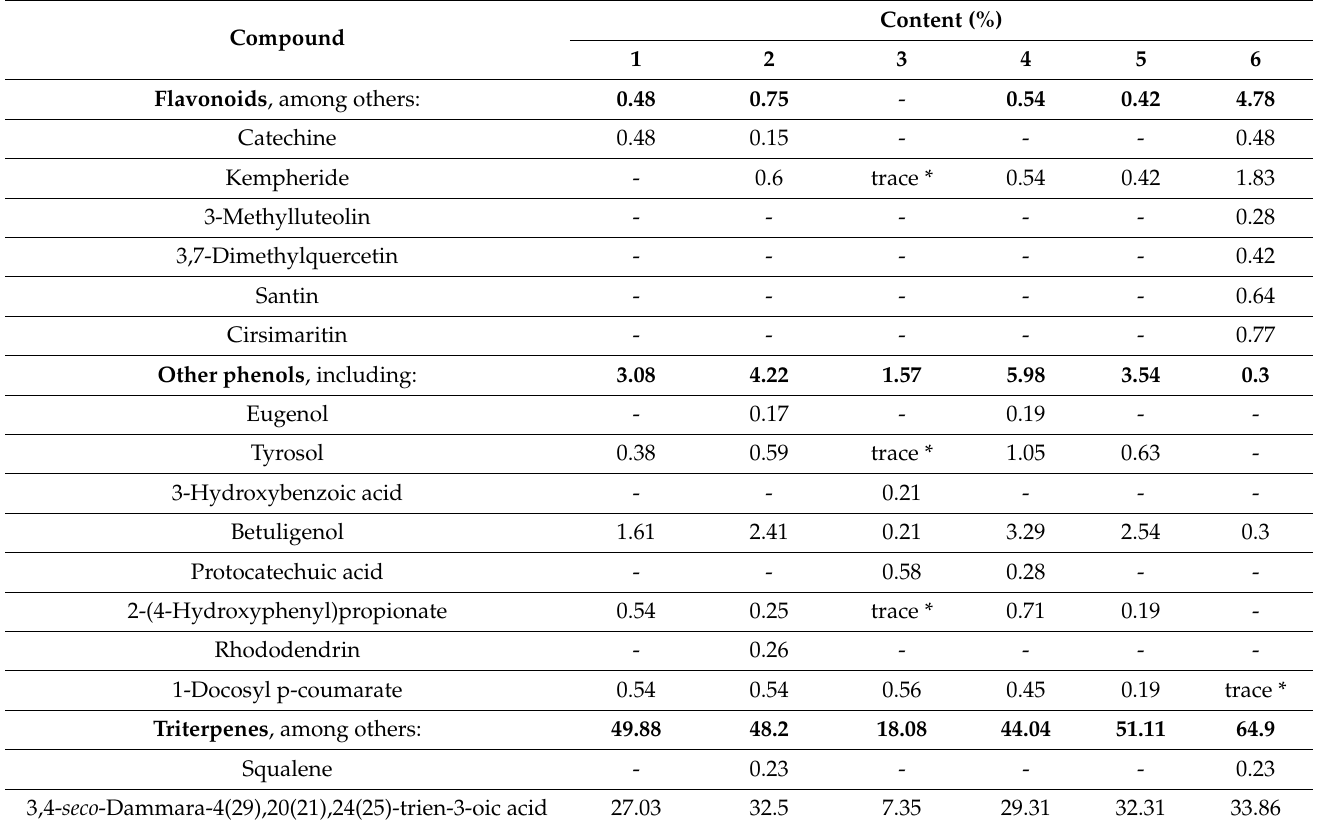
Figure 7. The degree of leaf damage according to the Khvasko scale. The lower and upper hinges correspond to the first and third quartiles (the 25th and 75th percentiles), and the center line corresponds to the median. The upper whisker extends from the upper hinge to the largest value no further than 1.5 * IQR from the hinge (where IQR is the inter-quartile range or distance between the first and third quartiles). Likewise, the lower whisker extends from the lower hinge to the smallest value no further than 1.5 * IQR from the hinge. Points were jittered in order to avoid overplotting of identical values. Table 2. The chemical composition of extracts from birch shoots in the treatments: Control ( 1 ), Defoliation 30% ( 2 ), Defoliation 60% ( 3 ), P. plurivora ( 4 ), P. plurivora + defoliation 30% ( 5 ), P. plurivora + defoliation 60% ( 6 ). More details are given in Table S12. Detection error does not exceed 5% of a given